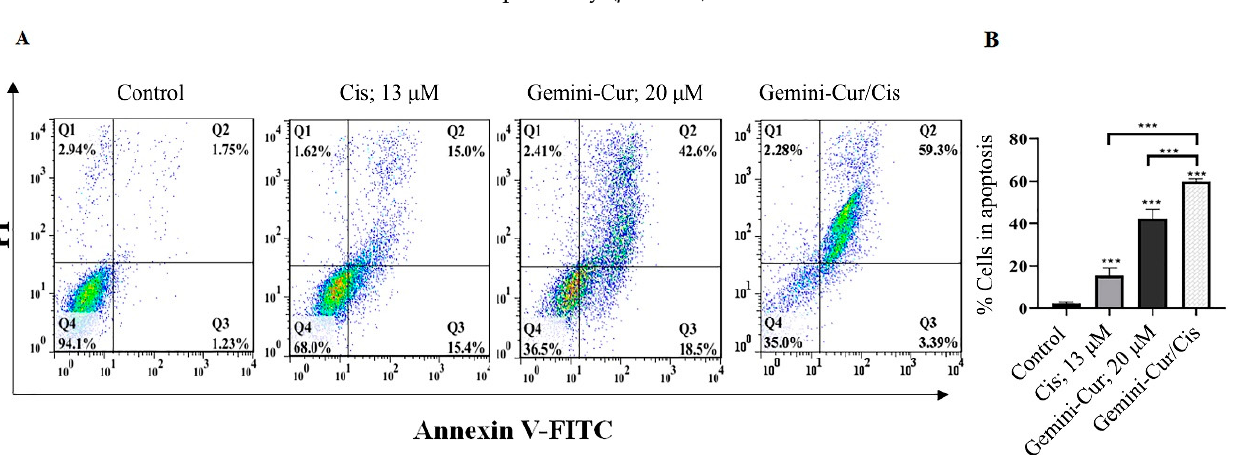
Figure 5. The combination of cisplatin and Gemini-Cur induces breast cancer cell apoptosis. MDA- MB-231 cells were treated with 13 μ M cisplatin, 20 μ M Gemini-Cur, and Gemini-Cur/Cis for 48 h. ( A ): plots show that live cells undergo apoptosis and the number of death cells is increased in treated cells, especially in Gemini-Cur/Cis group. ( B ) The proportion of apoptotic cells in late stage is sig- nificantly increased in combination treatment. ***: p < 0.001.